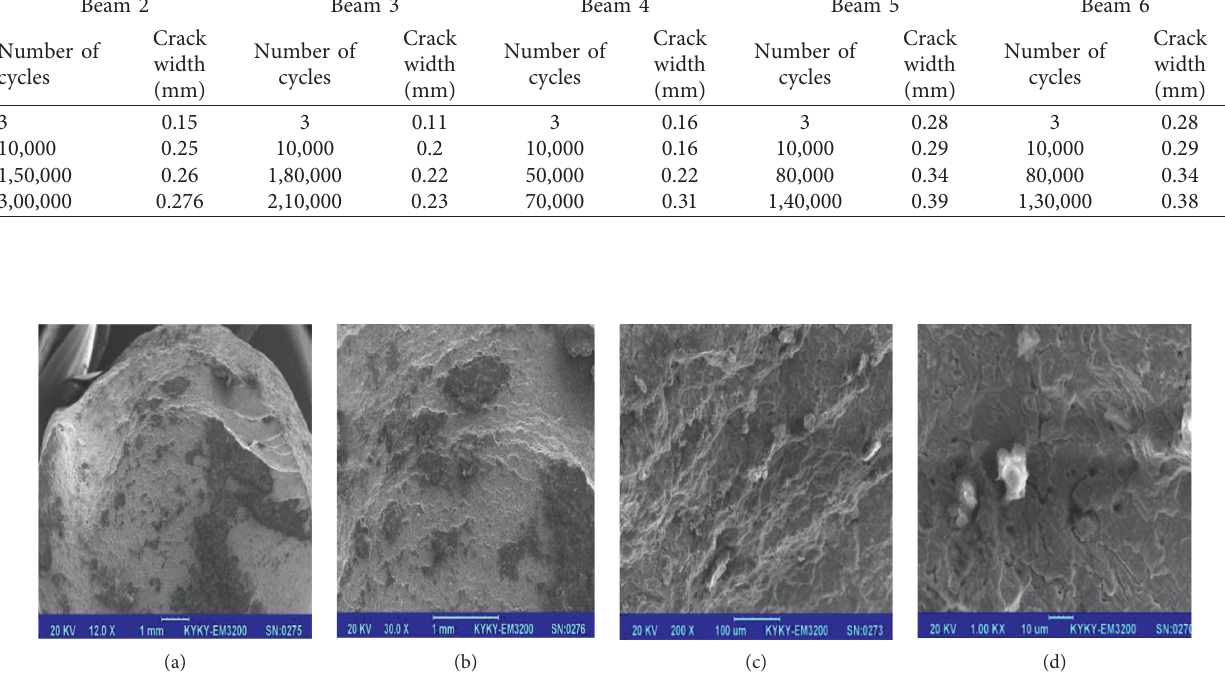
Figure 12: Steel fatigue failure surfaces of Beam 2. (a) Source zone. (b) Development zone. (c) Transition zone. (d) Fracture